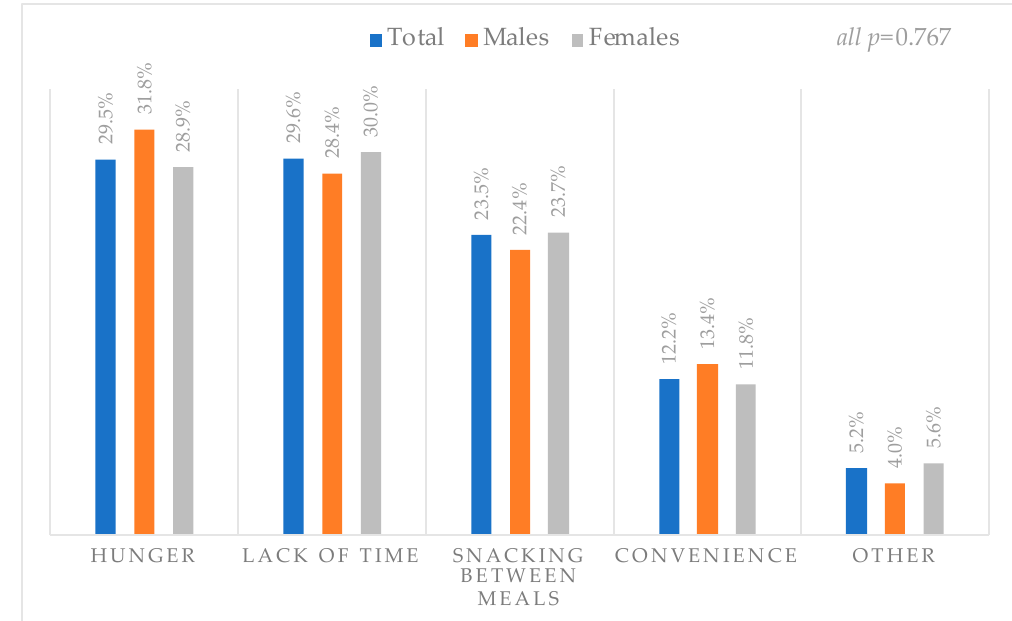
Figure 1. Reasons for purchase from the vending machine among users ( n = 937). The p -value indicates the statistical significance of the Chi-square test.